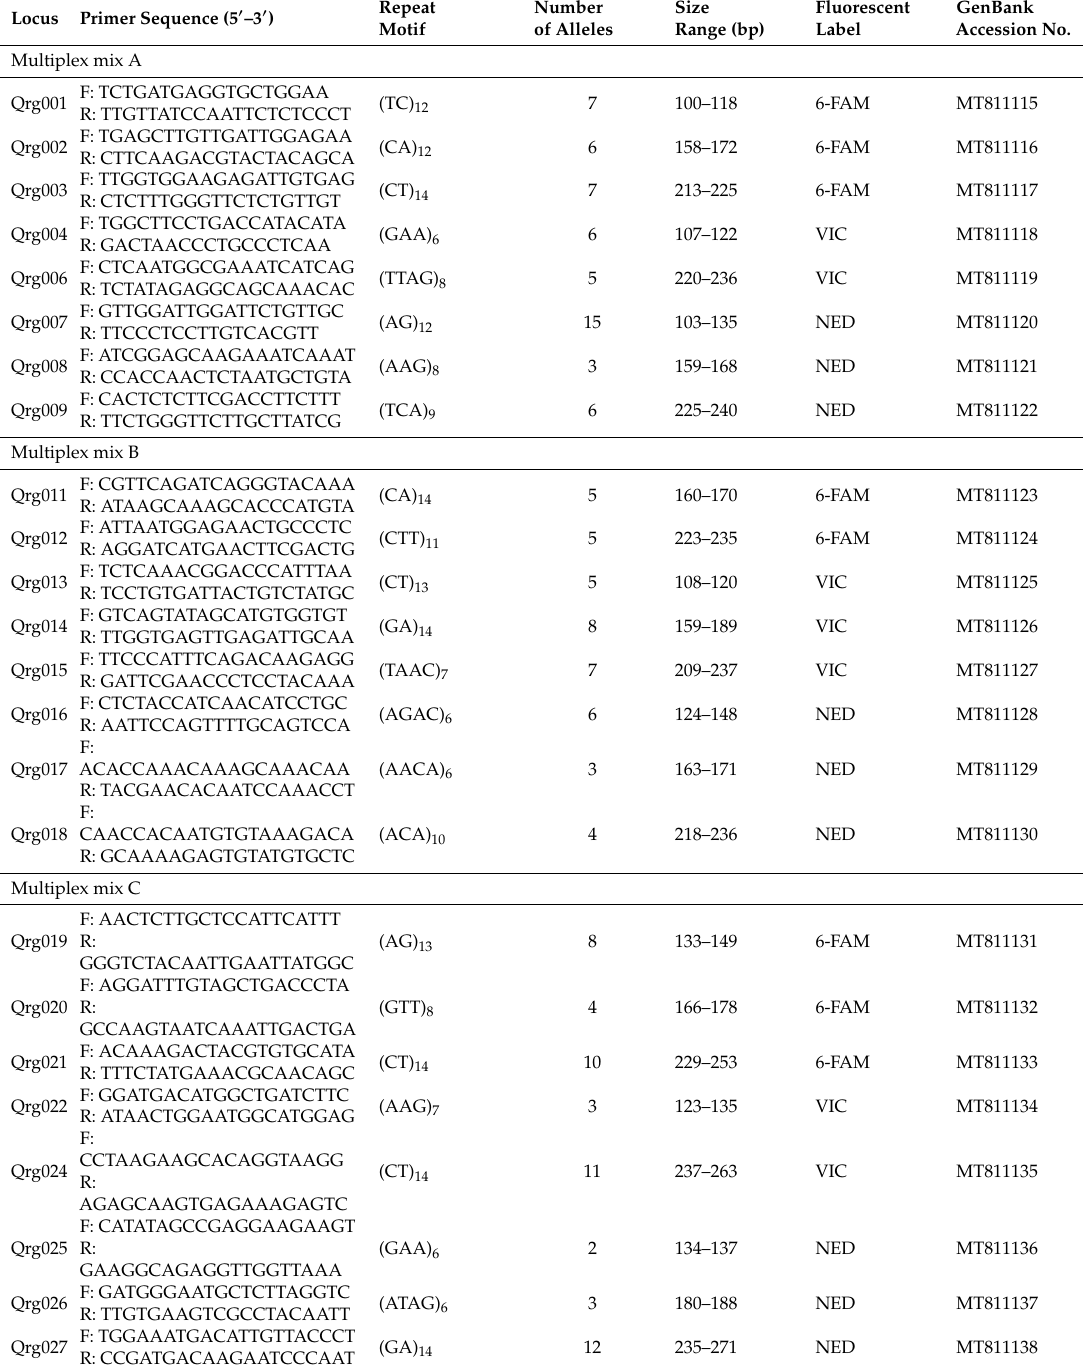
Table 1. Characterization of six multiplexes of 46 microsatellite loci for Quercus